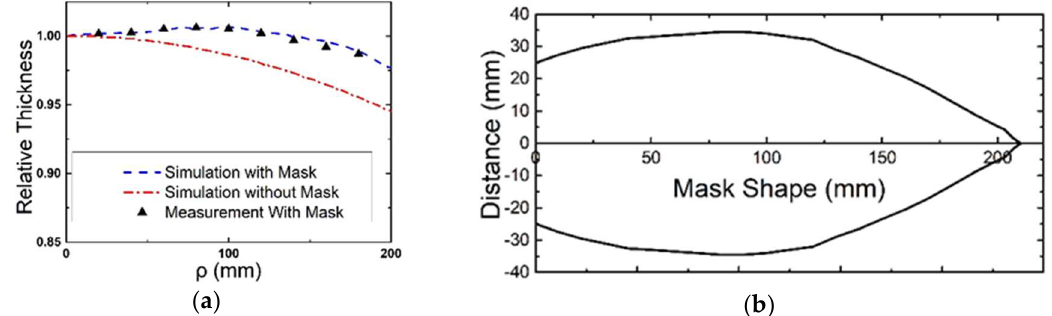
Figure 25. ( a ) The thickness distribution simulation with and without mask; ( b ) shape of the mask.